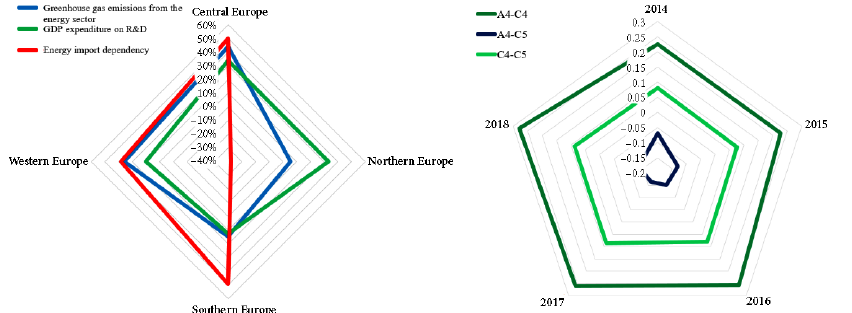
Figure 3. Regional A4, A5, C4, and C5 share from the analysed European area. The evolution of the Pearson correlation coefficient (source: authors’